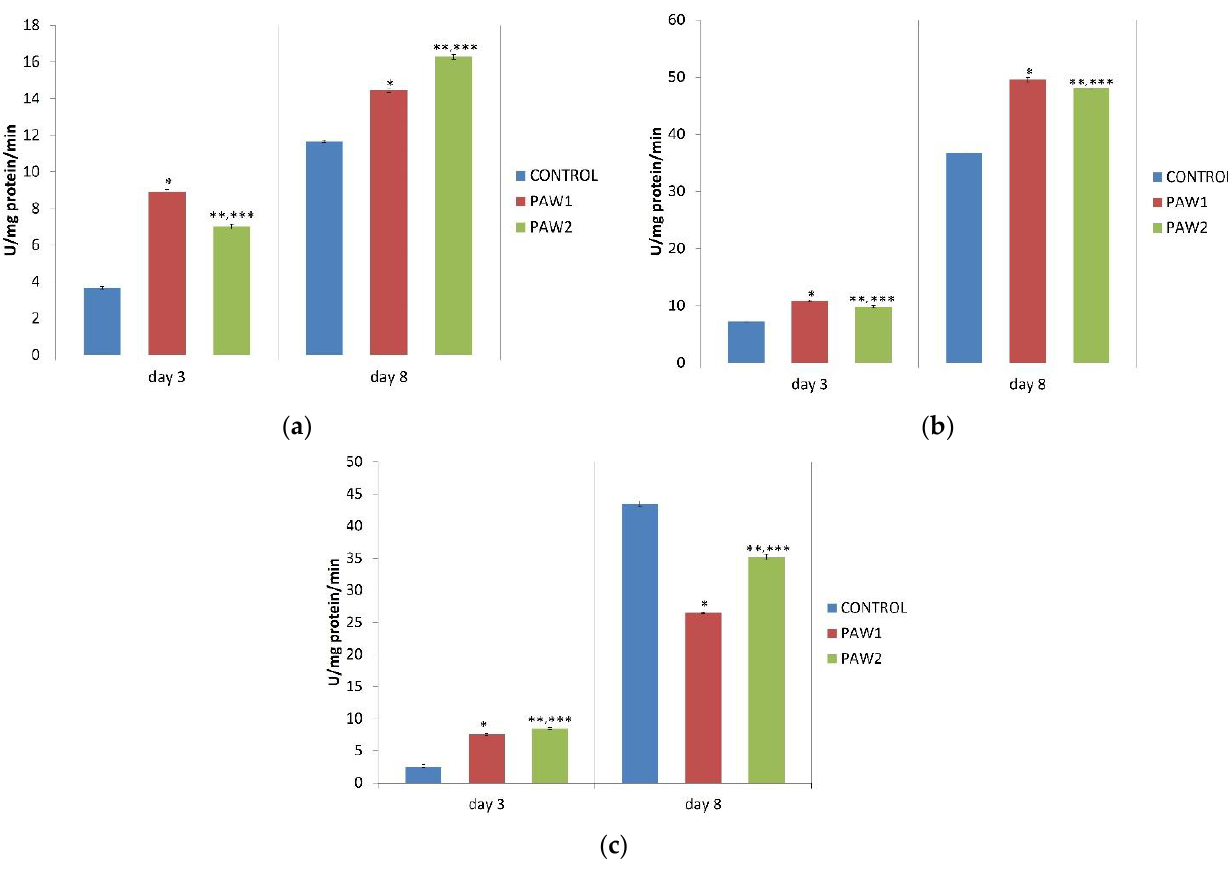
Figure 8. Activity of antioxidant enzymes SOD ( a ), CAT ( b ), and POX ( c ) in Triticum aestivum L. cv. Glosa sprouts (day 3) and shoots (day 8); * significant difference ( p < 0.05) between control and PAW1; ** significant difference ( p < 0.05) between control and PAW2; *** significant difference ( p < 0.05) between PAW1 and PAW2. Each point represents the mean ± SD of three determinations.